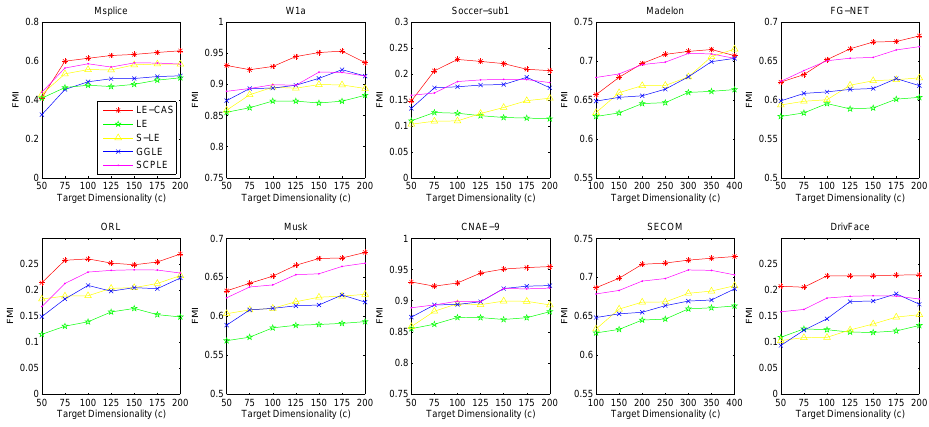
Figure 2. Results of FMI on ten datasets (Msplice, W1a, Soccer-sub1, Medelon, FG-NET, ORL, Musk, CNAE-9, SECOM, DrivFace) under different target dimensionalities ( c